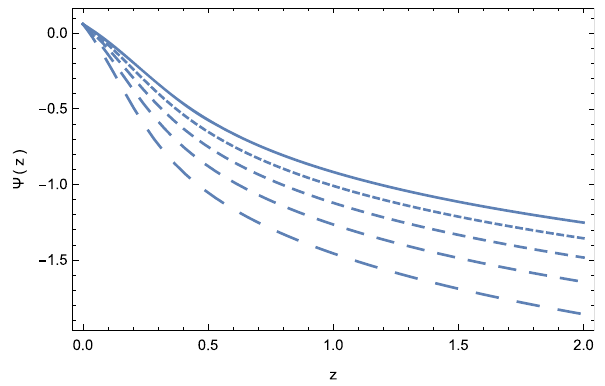
Fig. 13 Variation as a function of the redshift of the Weyl vector com- ponent (cid:18)( z ) for the geometry-matter coupling function F η e μ ˜ Q / 6 + ν ˜ T for M = 1 . 7, η = 6 /μ , ν = 20, and for different values of μ : μ = 1 . 7 (dotted curve), μ == 1 . 5 (short dashed curve), μ = 1 . 3 (dashed curve), μ = 1 . 1 (long dashed curve), and μ = 0 . 9 (ultra-long dashed curve). To integrate the system of cosmological evolution equa- tions we have used the initial conditions h ( 0 ) = 1, (cid:18)( 0 ) = 0 . 058, and (cid:4)( 0 ) = 0 . 0235